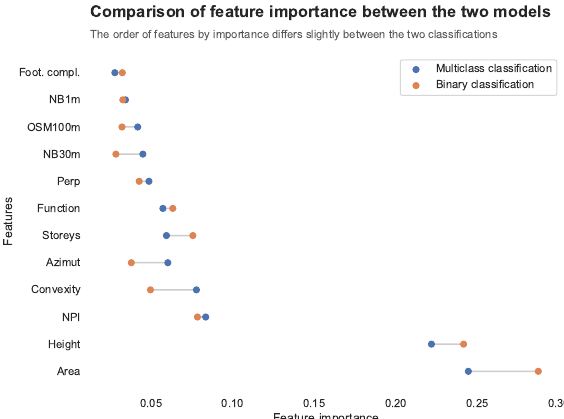
The performance is given for each roof type in Figure 6. While